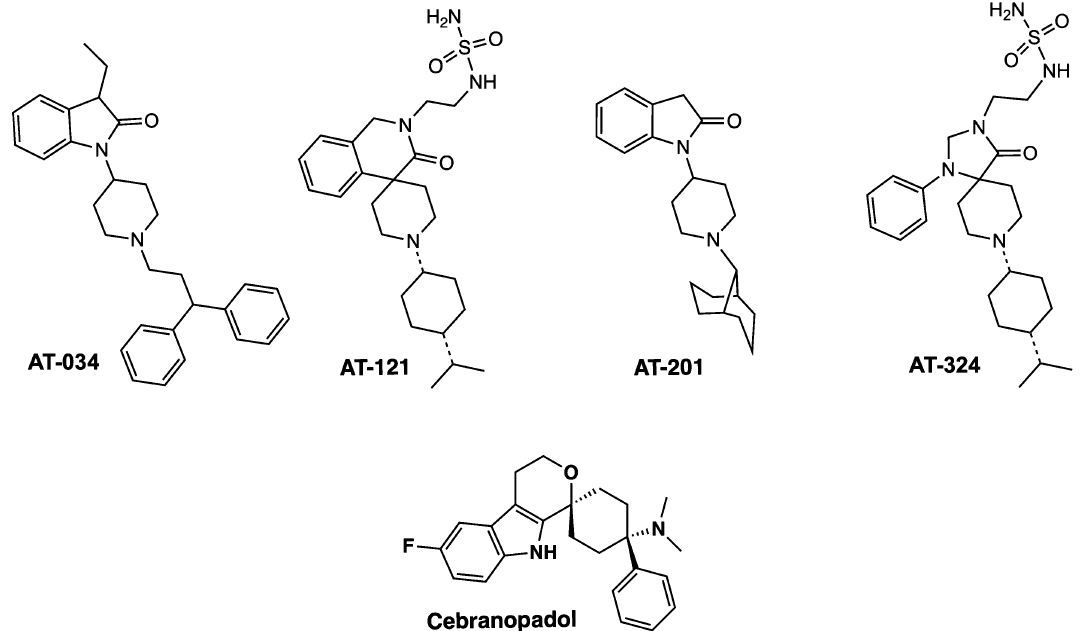
Figure 1. Chemical structures. Chemical structures of investigated novel mixed MOP/NOP agonists.